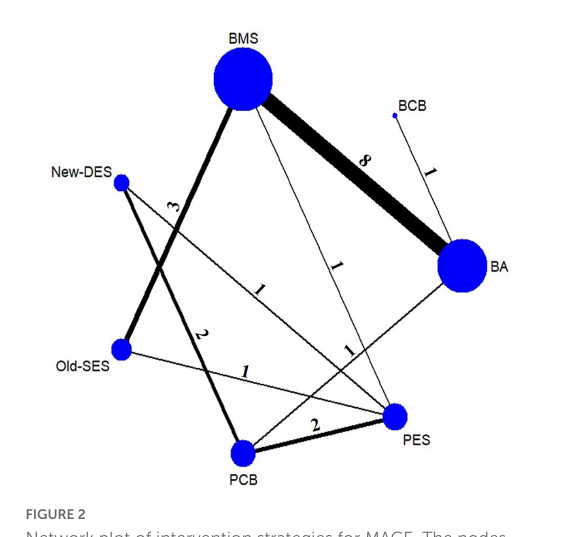
FIGURE2 Network plot of intervention strategies for MACE. The nodes indicate intervention strategies. The size of the nodes represents the sample size of the study. The line between nodes is the number of studies for direct comparison. BA, balloon angioplasty; BCB, biolimus-coated balloon; BMS, bare-metal stent; New-DES, new-generation drug-eluting stent; Old-SES, older generation sirolimus-eluting stent; PCB, paclitaxel-coated balloon; PES, paclitaxel-eluting